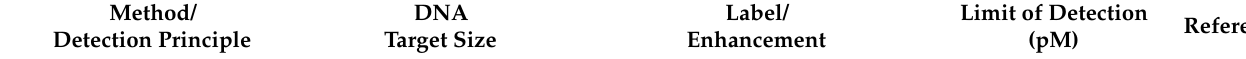
Table 2. Analytical performance of the methods developed for quantitative determination of DNA with different detection techniques, including enhancement of the nanoparticle